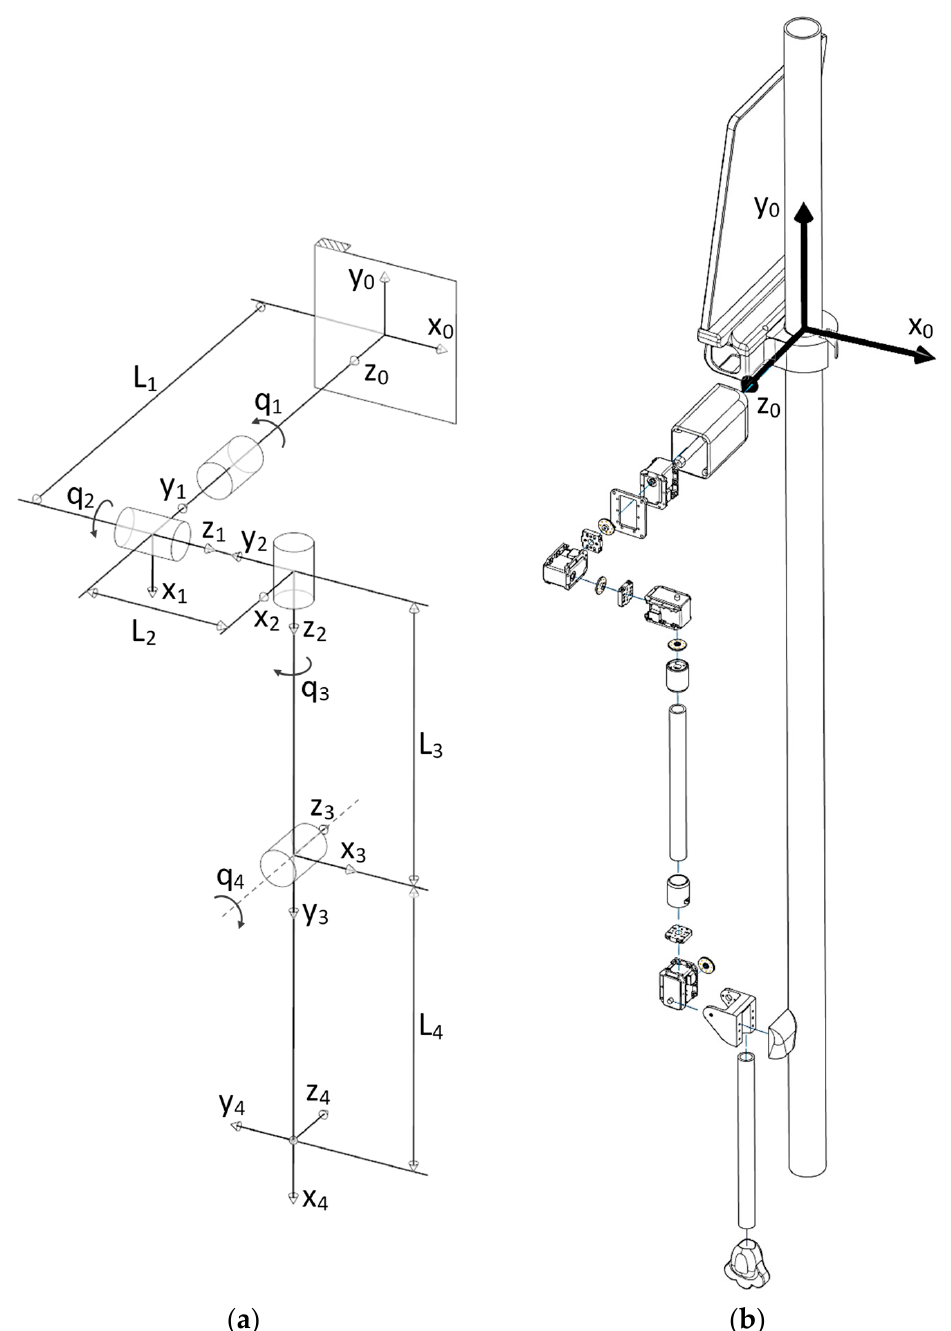
Figure 5. Representation of the left articulated arm of the mobile robot (seen from its back): ( a ) sim- plified kinematic representation and ( b ) exploded view of the parts of the arm.